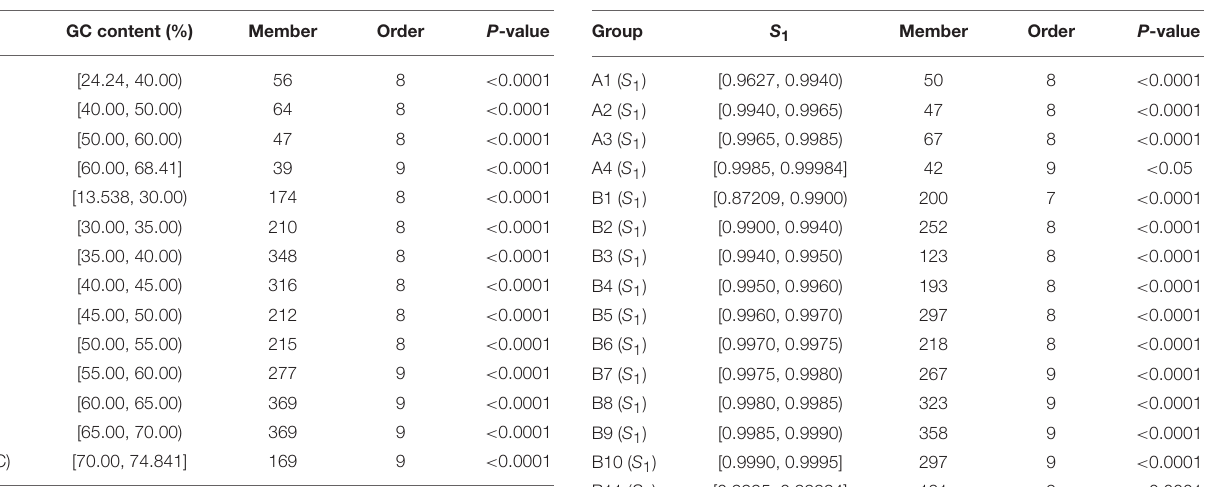
TABLE 2 | Extent of strand symmetry determined by word symmetry distance analysis ( WSD 2 and nWSD 2) in groups of archaeal and bacterial genomes classified according to their mononucleotide symmetry levels ( S 1